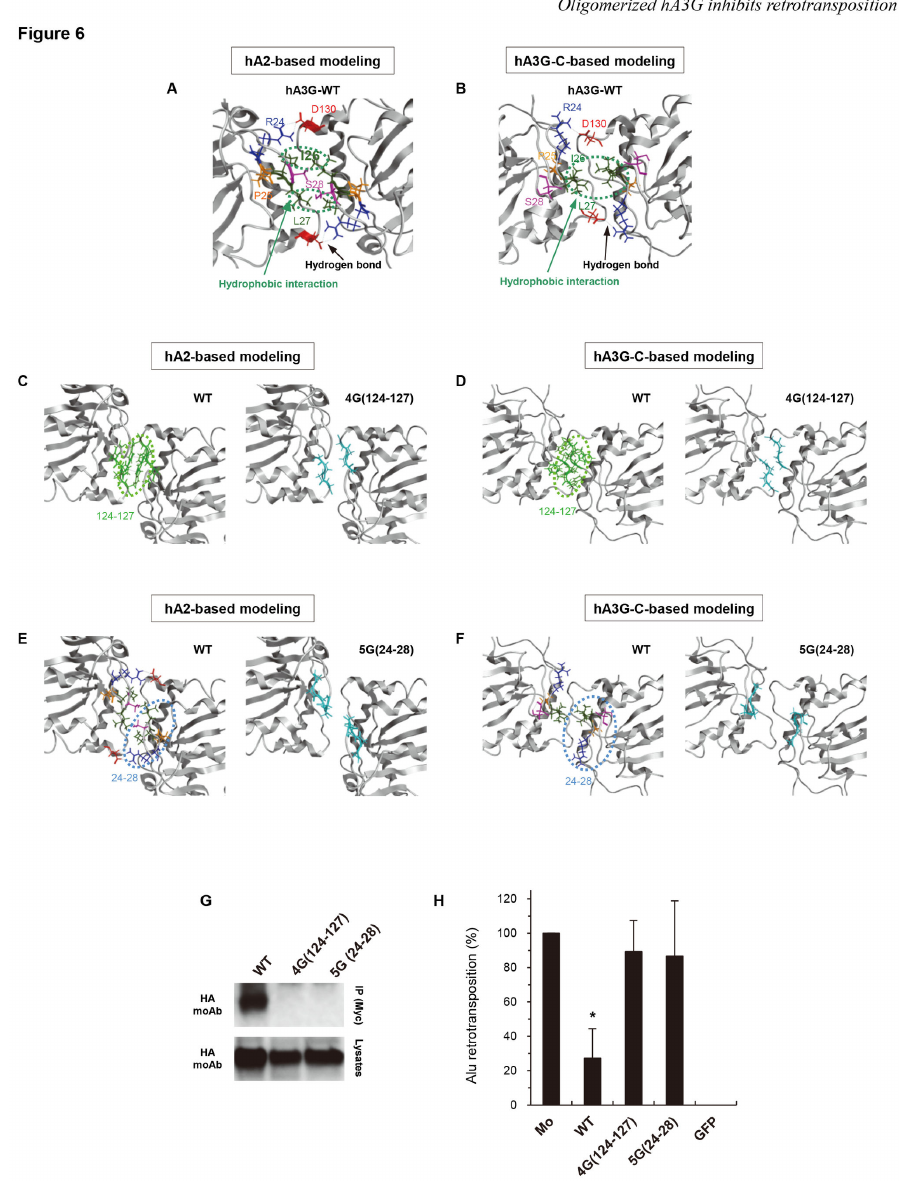
Figure 6. Residues 24–28, as well as known residues 124–127, contribute to the ability of hA3G to homooligomerize and its inhibitory activity against Alu retrotransposition. (A–F) Structural models of hA3G dimer based on the human APOBEC2 (hA2) crystal structure (A, C, and E) and the C-terminal hA3G (hA3G-C) NMR structure (B, D, and F). ( A , B ) The interaction surface of the hA3G N-terminal domain in the head-to-head dimer is shown. The hydrophobic interactions formed between either I26 or L27 (green) and their counterpart residues of another monomer (green) are encircled by green dotted lines. A hydrogen bond is formed between a basic residue R24 (blue) and another monomer’s D130 (red). Another hydrogen bond is formed between the S28 residues (pink) of two monomers. Structural stability may be conferred by P25 (orange). ( C , D ) The dimer interface at amino acid residues 124–127. Left panel, the aromatic amino acid cluster (YYFW) at positions 124–127 is depicted in light green; right panel, the substitution of these residues with glycines is shown in cyan. ( E , F ) The dimer interface at amino acid residues 24–28. Left panel, the dimer interface residues (RPILS) at positions 24–28 are depicted in colors similar to those in A; right panel, substitution of these residues with glycines is shown in cyan. ( G ) IP-Western blot analysis was performed as described in Figure 4; upper, IP; lower, cell lysates. ( H ) An Alu retrotransposition assay was performed as described in Figure 1. Crystal violet-stained G418R colonies were counted to determine the level of Alu retrotransposition. The data shown are the mean ±SD of triplicate experiments. Mo, mock; WT, wild-type hA3G; GFP, GFP only. *P < 0.05, **P < 0.005, t-test. doi: 10.1371/journal.pone.0084228.g006 PLOS ONE |